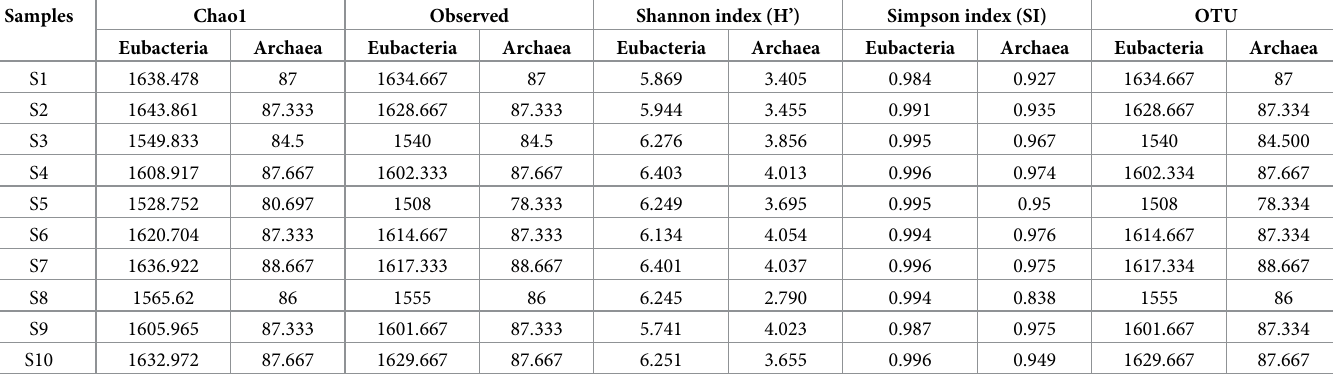
Shannon index–higher number represents higher diversity; Simpson index–higher number represents lower diversity; Chao1 index–higher number represents higher species